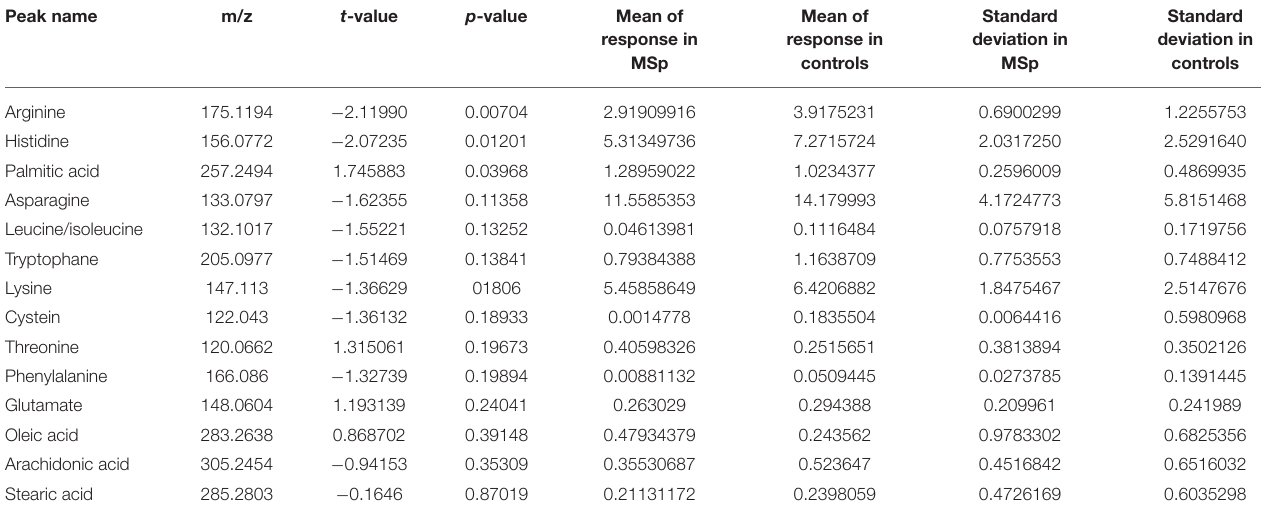
TABLE 1 | Detailed results of cerebrospinal fluid (CSF) analysis.